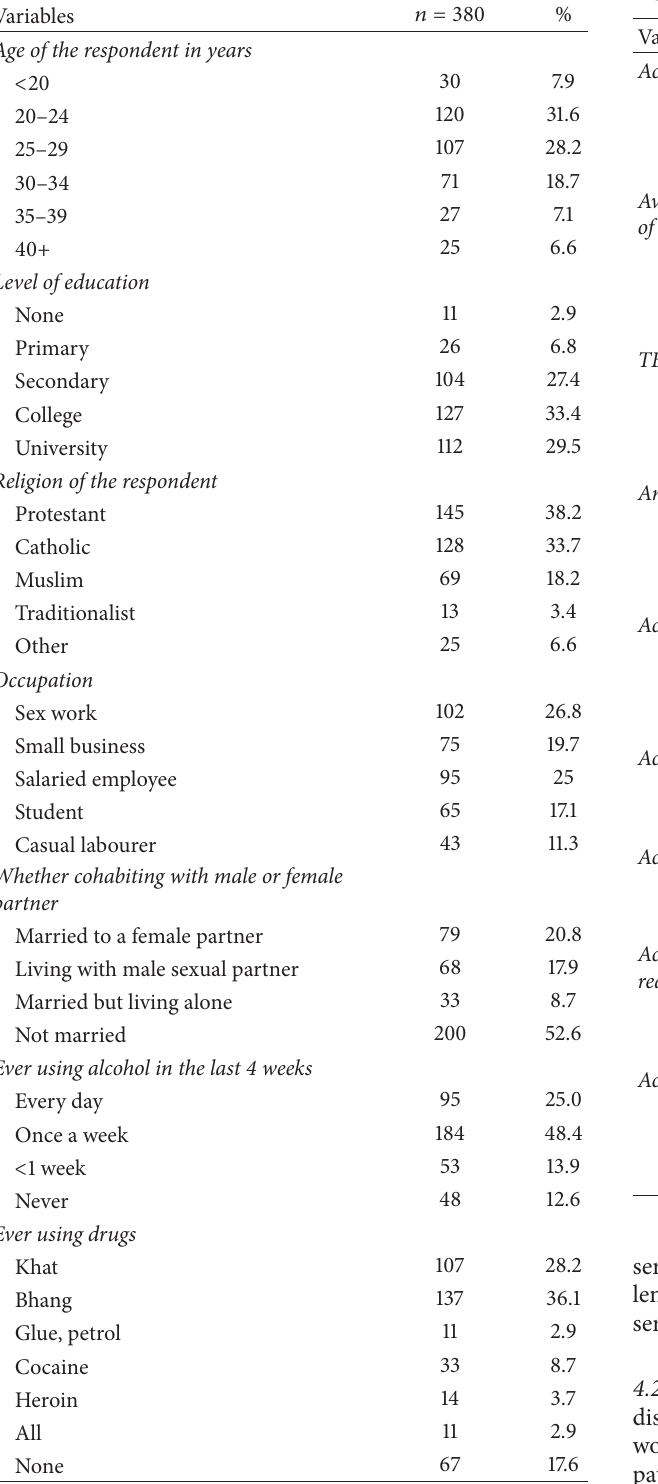
Table 1: Sociodemographic and behavioral characteristics of MSM. Table 2: Accessibility to HIV/AIDS prevention services among